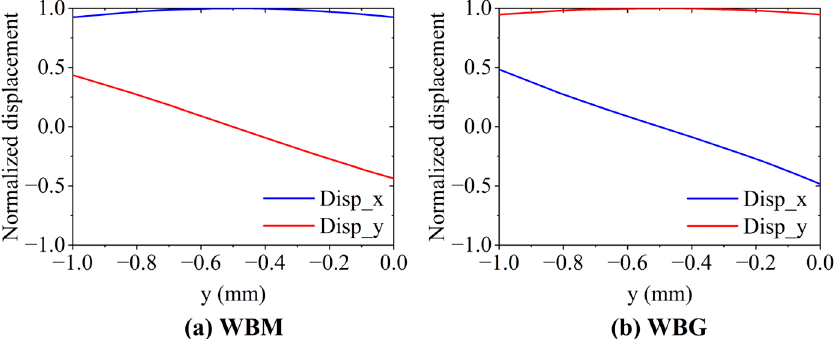
Figure 13. Normalized displacement on the line at x = 60 mm along the plate thickness in ( a ) the WBM model at 14.5 μ s and ( b ) the WBG model at 32.5 μ s.